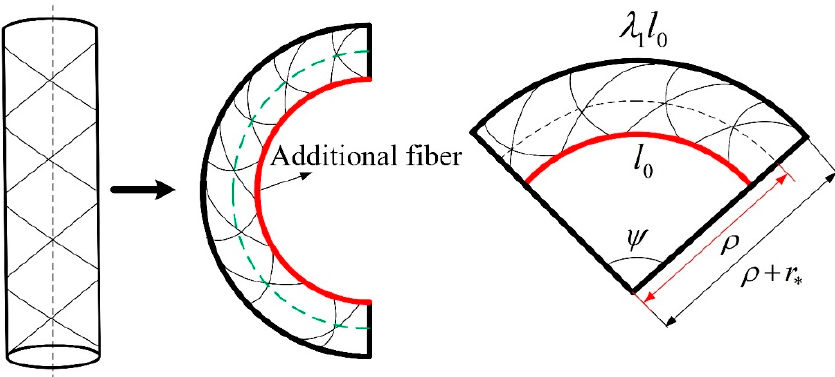
ψ is the bending angle and